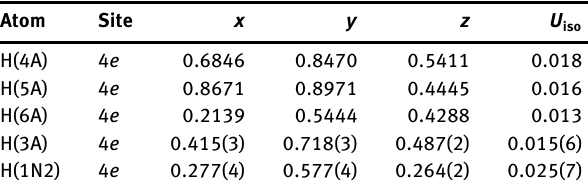
Table 2: Fractional atomic coordinates and isotropic or equivalent isotropic displacement parameters (Å 2